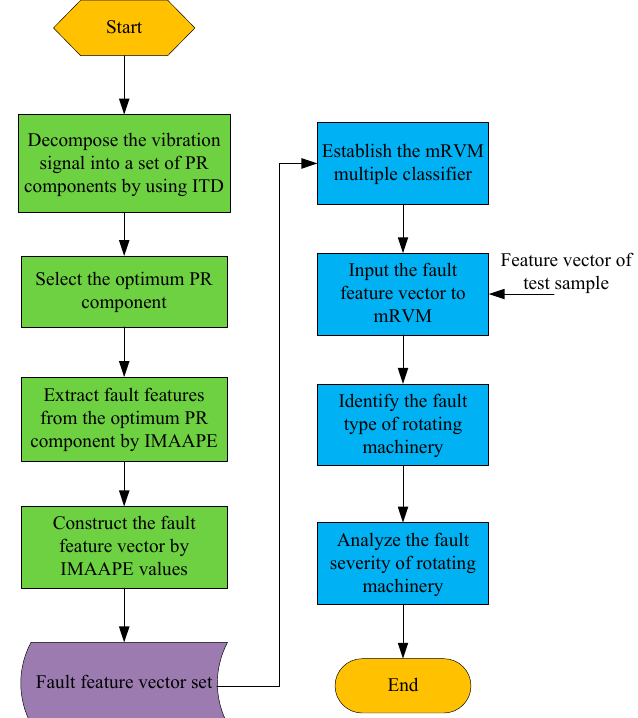
Figure 4. The proposed fault diagnosis procedure based on the improved multiscale amplitude-aware permutation entropy (IMAAPE) and mRVM.